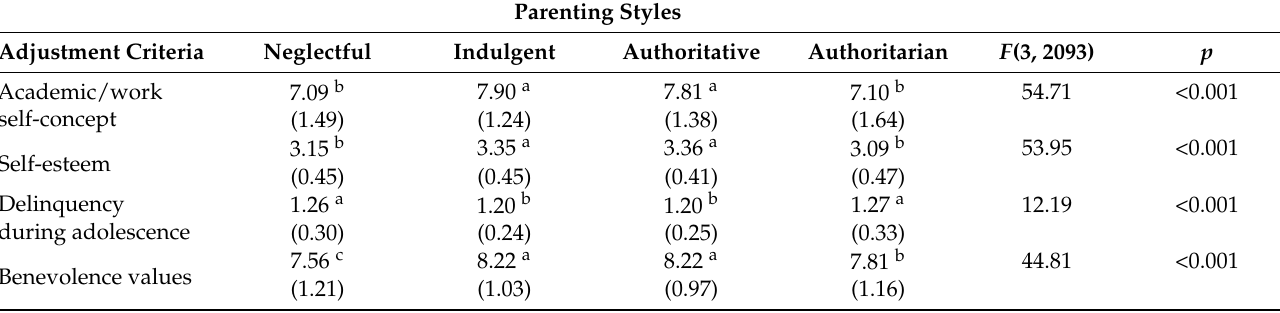
Table 4. Means, standard deviations, univariate F -values, and Bonferroni’s post hoc analysis of parenting styles for academic/professional self-concept, self-esteem, delinquency during adolescence, and benevolence